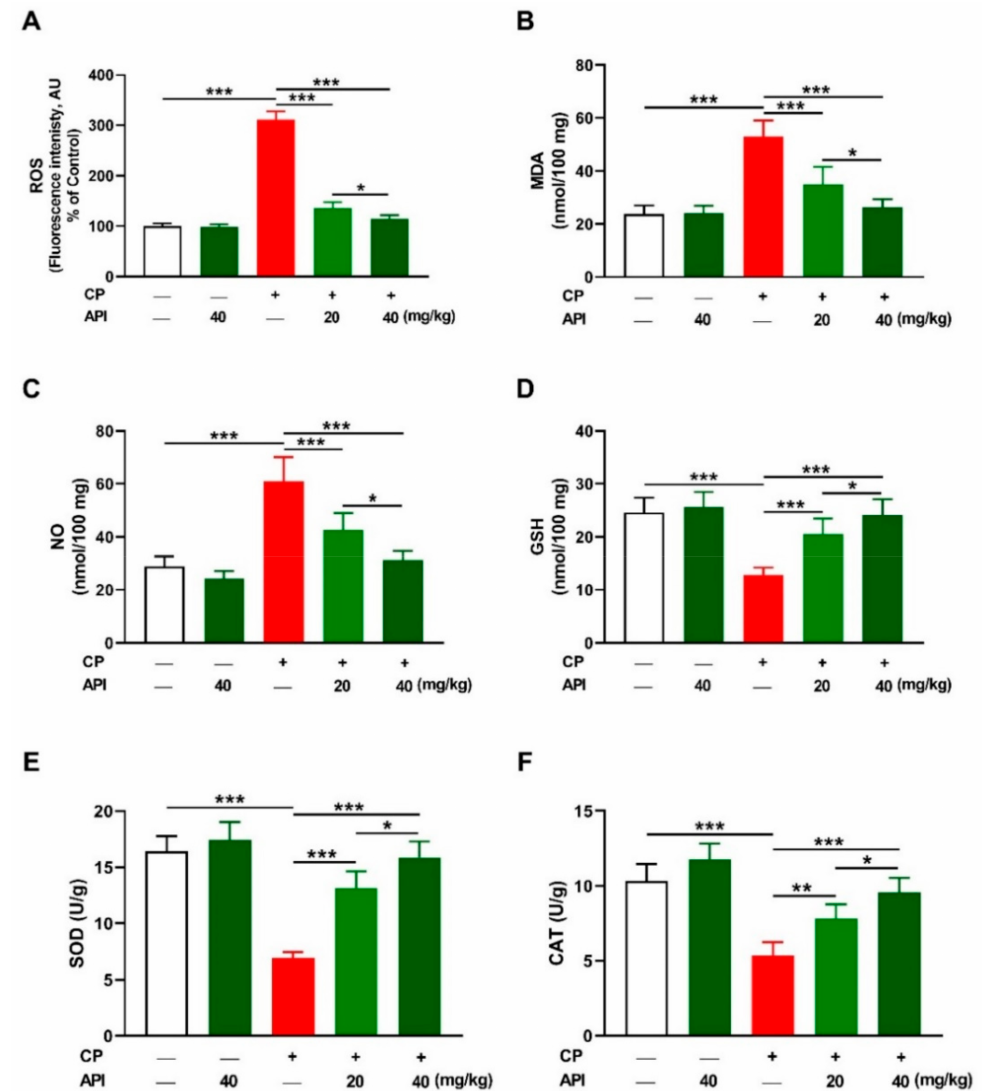
Figure 4. API attenuated CP-induced hepatic oxidative stress. API decreased ( A ) ROS, ( B ) MDA, and ( C ) NO, and increased ( D ) GSH, ( E ) SOD, and ( F ) CAT in the liver of CP-administered rats. Data are mean ± SEM, ( n = 6). * p < 0.05, ** p < 0.01, and *** p < 0.001.